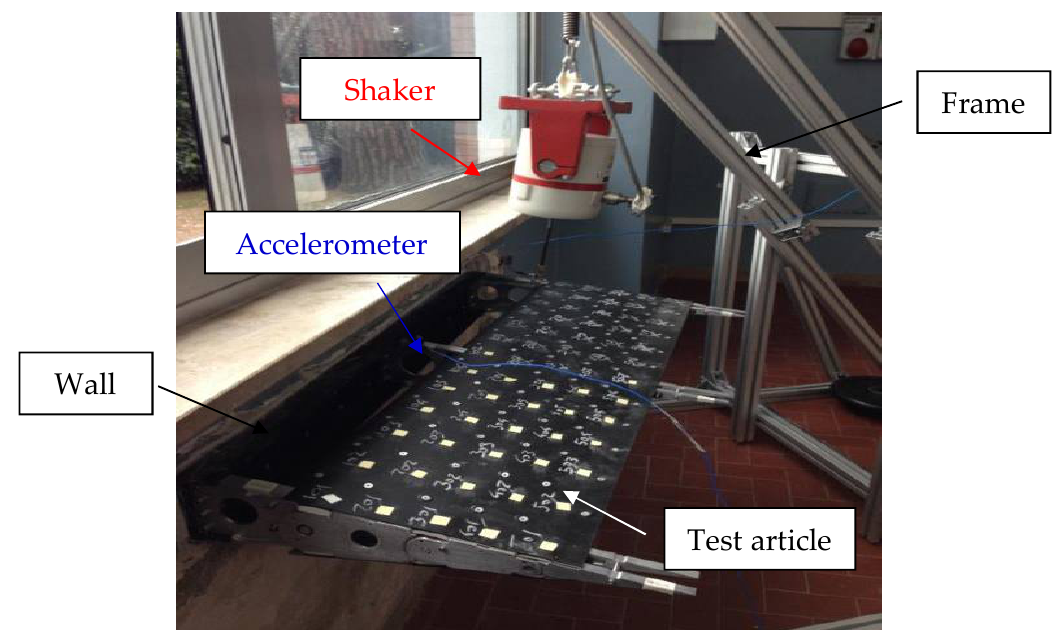
Figure 22. GVT setup: boundary conditions and electromechanical exciter.